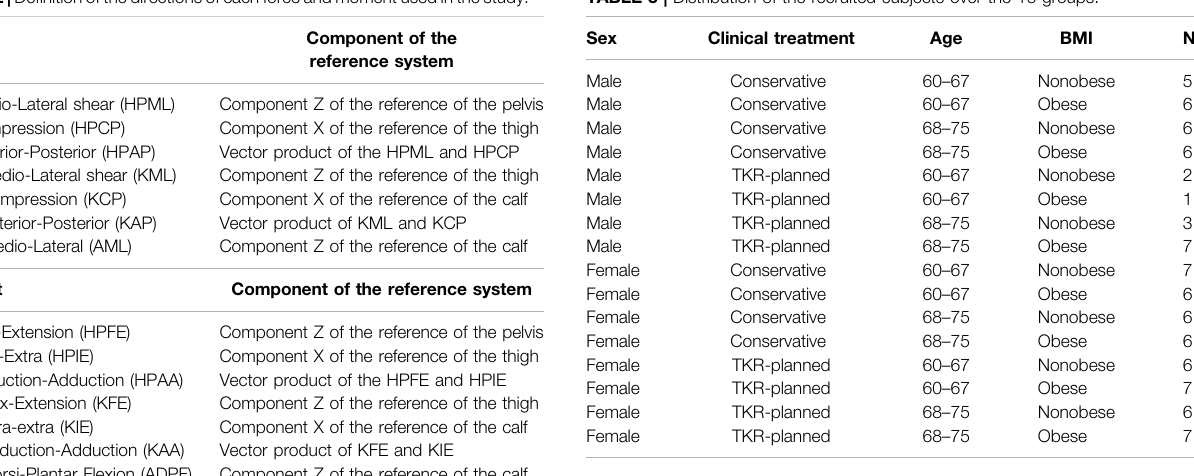
TABLE 3 | Distribution of the recruited subjects over the 16